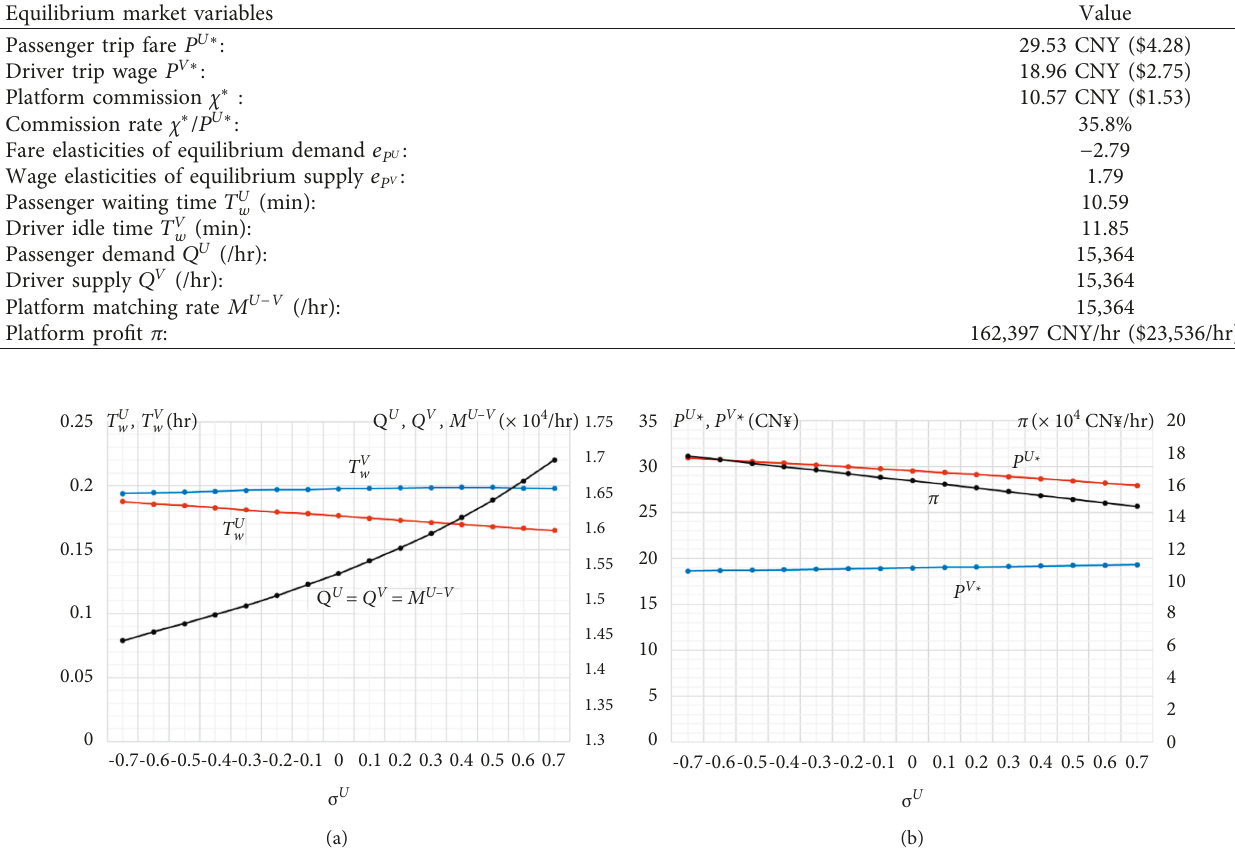
T V Q U , Q V , and M U − V . (b) Changes in w , w ,